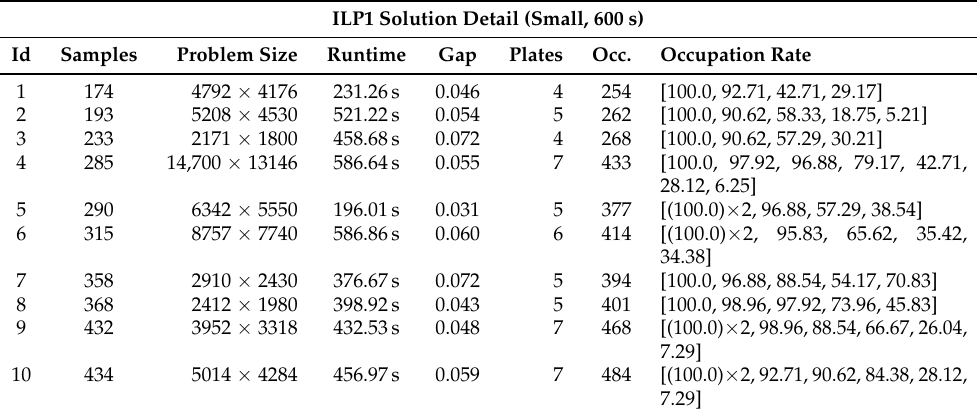
Table A5. ILP1 results obtained for small size files, limited to 600s. Runtime column shows time stamp of best solution achieved.